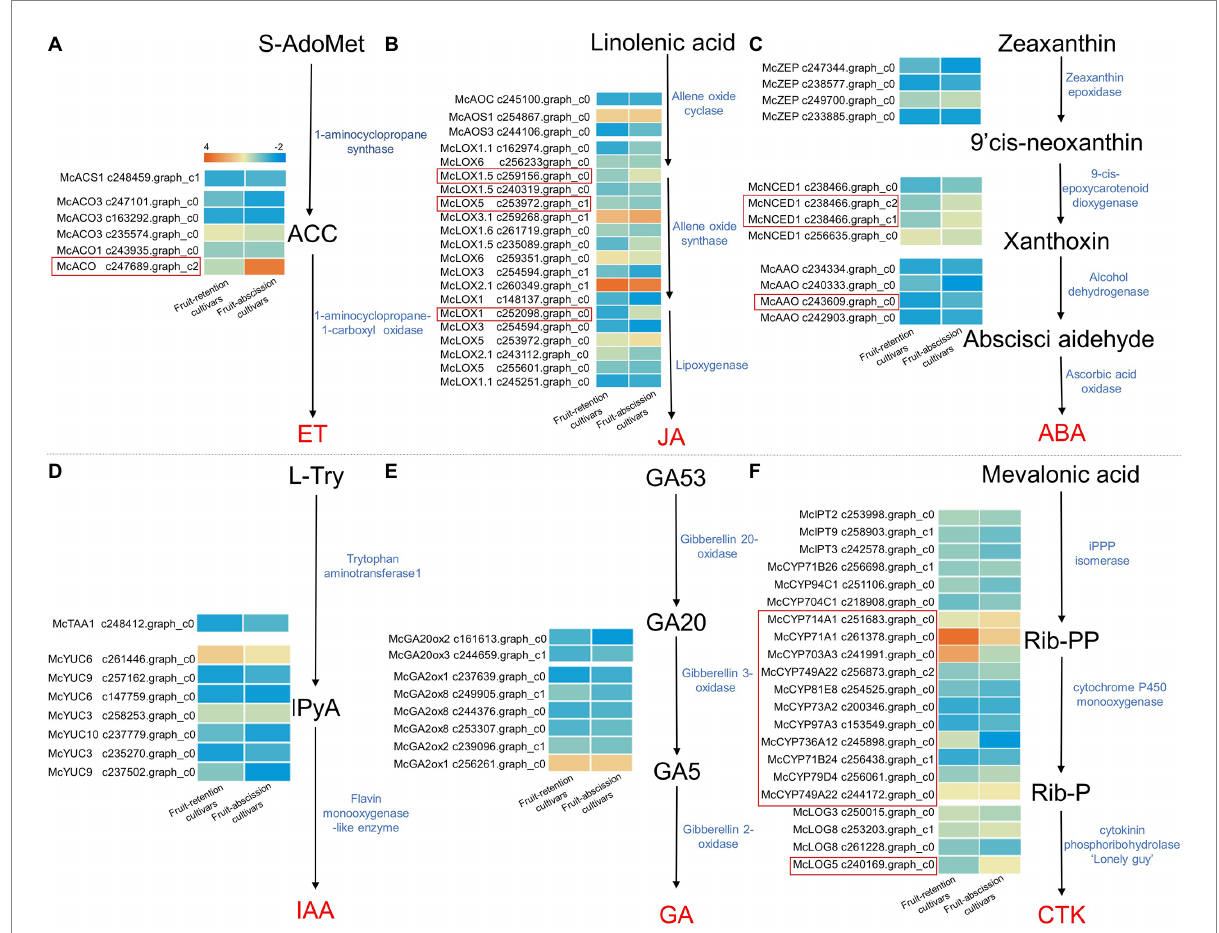
FIGURE 3 Schematics of biosynthesis differential transcript profiles of hormone-related genes. Genes up- or downregulated in all stages in fruit-retention and -abscission cultivars were denoted by light orange and blue, respectively. (A) Ethylene; (B) Jasmonic acid; (C) Abscisic acid; (D) Auxin; (E) Gibberellin; and (F)